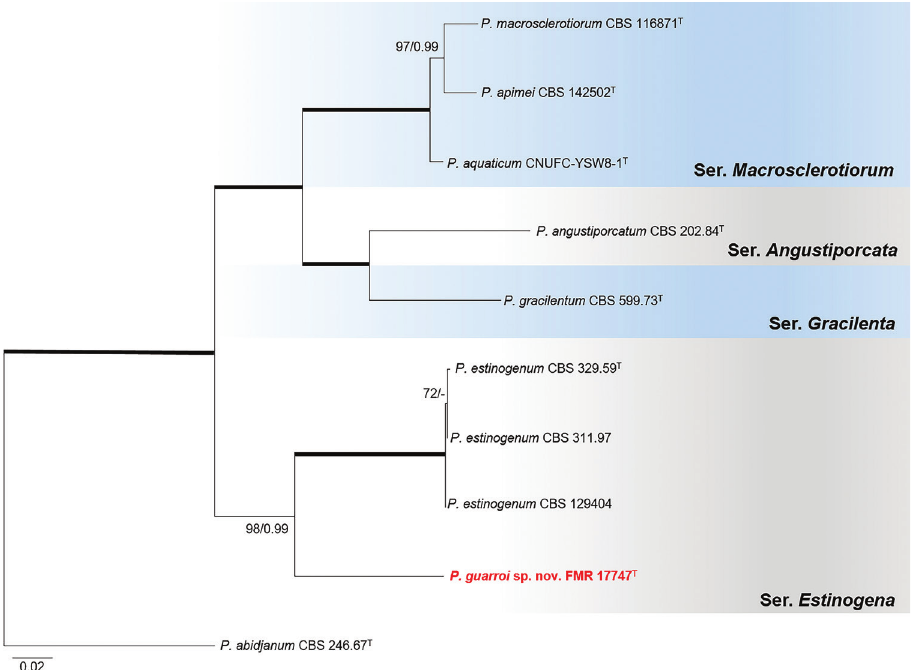
Figure 7. Phylogenetic tree of Penicillium section Gracilenta based on ML analysis obtained by RAxML inferred from the combined tub 2, cmdA , ITS, and rpb 2 loci. Branch lengths are proportional to phy- logenetic distance. Bootstrap support values/Bayesian posterior probability scores above 70%/0.95 are indicated on the nodes. Bold branches indicate bs/pp values 100/1. The tree is rooted to P. abidjanum CBS 246.67. The name in red is the new species described in this study. T = Ex-type